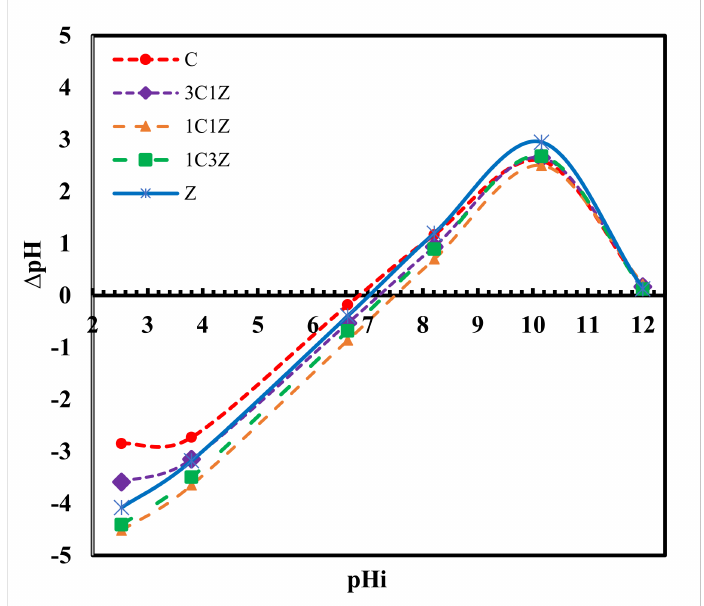
Figure 7. pH of zero point charge of Z, 1C3Z, 1C1Z, 3C1Z, and C greenly prepared via hydrothermal route (pH = 10, T = 250 ◦ C, t = 2.5 h) and calcination for 2 h at 300 ◦